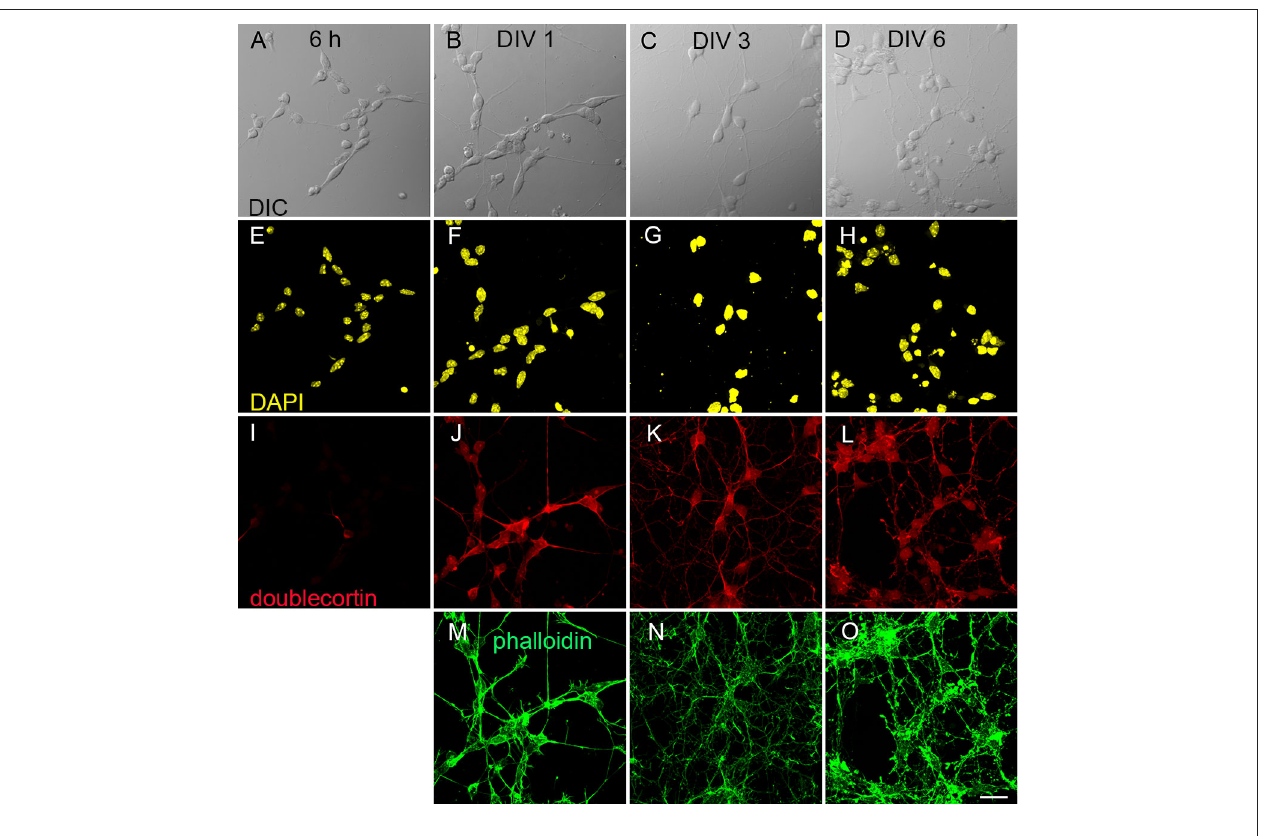
(D) at DIV 6. (E–O) Immunostainings against neuronal markers at the corresponding DIV. (E–H) Nuclear staining with DAPI. (I–L) Labeling against the marker for immature neurons doublecortin. (M–O) Actin staining with phalloidin. Scale bar: 20 µ